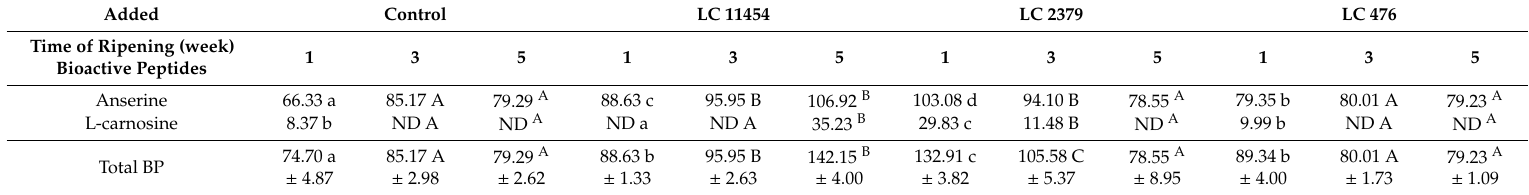
Table 6. Concentrations of bioactive peptides (BP) in Dutch-type cheese models during ripening (mg · kg − 1 ). Added Time of Ripening (week) Bioactive